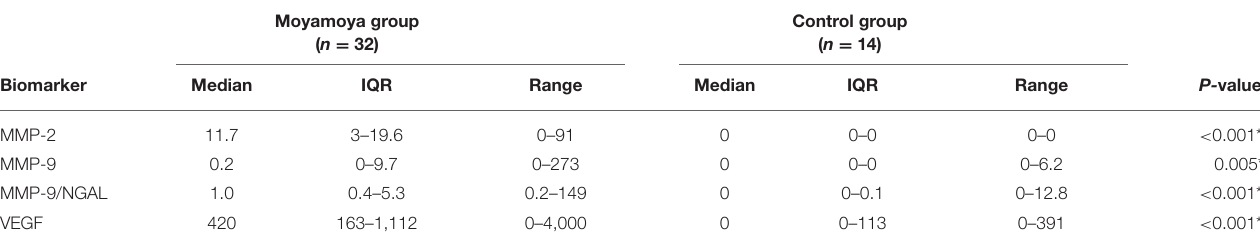
TABLE 1 | Comparison of urinary MMPs and VEGF for moyamoya disease patients and controls.